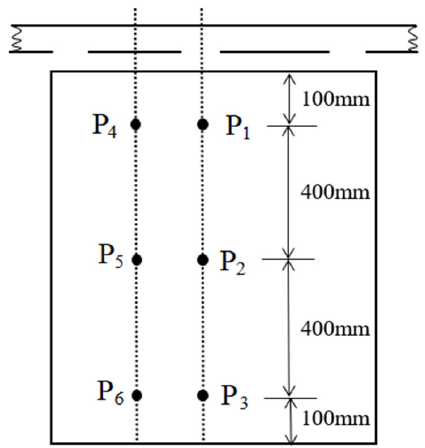
Figure 3. Pressure points with positive and non-positive pulse airflow.